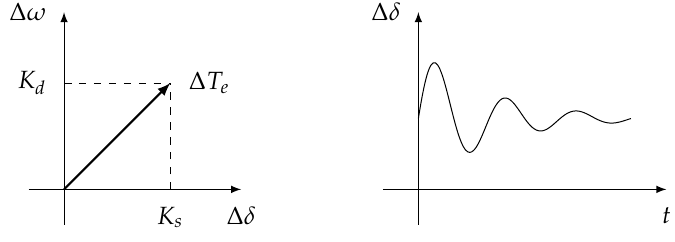
Figure 1. Complex plane of ∆ T e ( t ) and ∆ δ ( t ) response in stable condition.